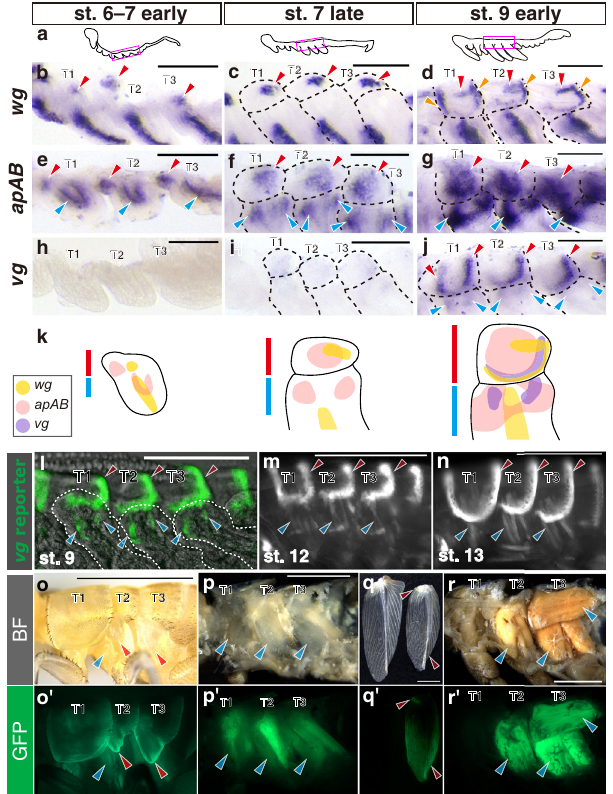
Fig. 1 Expression pattern of wg , apAB and vg in thoracic segments of Gryllus . a Schematics illustrate lateral views of Gryllus embryos in each stage. Magenta rectangle indicates the region shown in b – j . Dorsolateral regions of thoracic segments stained for wg ( b – d ), apAB ( e – g ) and vg ( h – j ) with in situ hybridization in stage 6 to early stage 7 ( b , e , h ), late stage 7 ( c , f , i ) and early stage 9 ( d , g , j ). Each image shows a representative result of at least three independent experiments with similar results. k Summary of gene expression pattern in meso- and metathoracic segments. Red and blue lines indicate tergal and pleural regions, respectively. l – n vg reporter gene signals in dorsolateral regions of thoracic segments in late embryos. o – r and o ’ – r ’ vg reporter gene signals in postembryonic stages. Dorsolateral region ( o , o ’ ) and thoracic musculature in median section ( p , p ’ ) of sixth instar nymph, and forewing ( q , q ’ ) and thoracic musculature in median section ( r , r ’ ) of adult. Crickets before cuticle coloration are shown for both nymph and adult. Red and blue arrowheads indicate expression in tergal and pleural regions, respectively. Scale bars are 100 µ m in b – j , 250 µ m in l – n and 3 mm in o – r ,